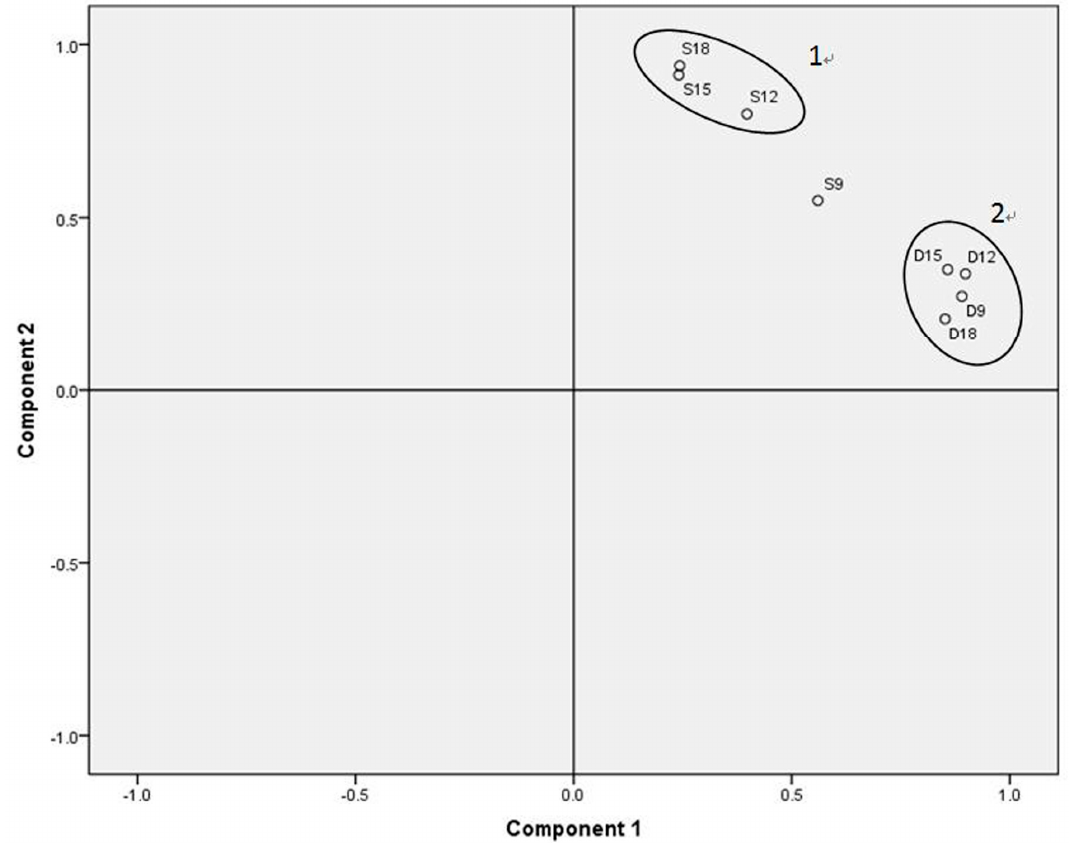
Figure 7. Principal components loadings for different pretreatment methods. D9, D12, D15 and D18 refer to Jinhua ham processed for 9, 12, 15 and 18 months and application of DHS for aroma extraction of samples, respectively. S9, S12, S15 and S18 refer to Jinhua ham processed for 9, 12, 15 and 18 months and application of SAFE for aroma extraction of samples,